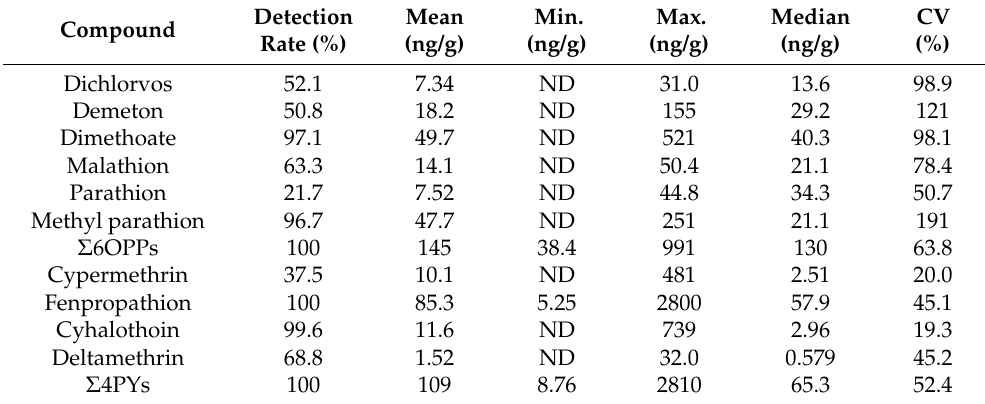
Table 1. The concentration of the target OPPs and PYs in soils from the PRD region. Detection Mean Compound Rate (%) (ng/g)